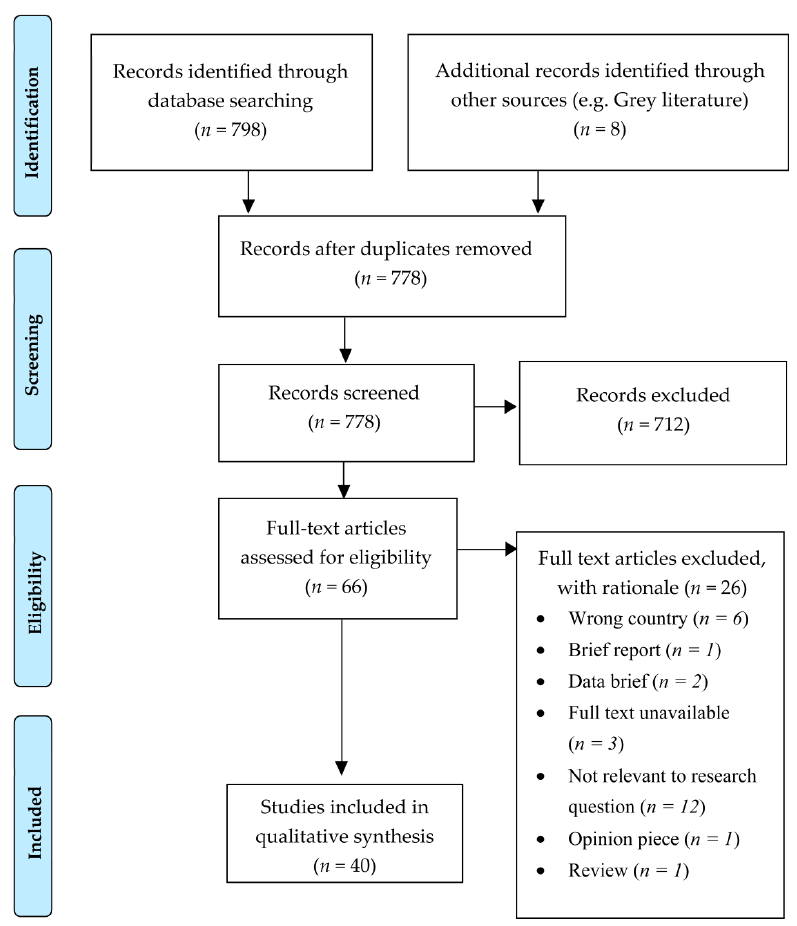
Figure 1. PRISMA 2009 flow diagram [15], detailing the number of studies included and excluded at each stage of the screening process.